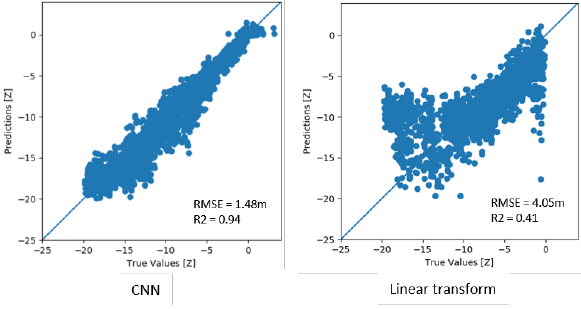
Figure 6. Depth prediction vs ground truth.